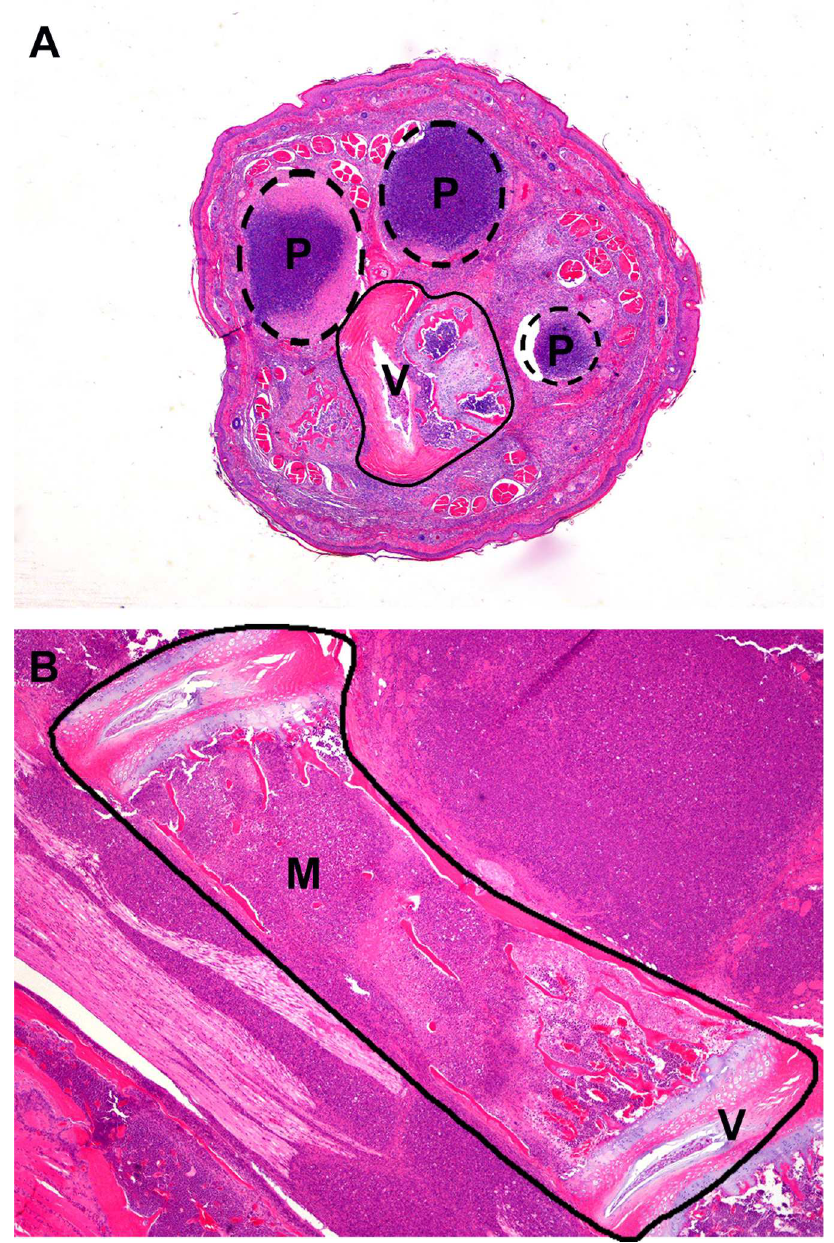
Fig 3. Histopathology observed in mice with rear leg clinical signs assocaited with IP challenge with B . pseudomallei K96243.(A) C57BL/6euthanizedon day 22 post-infection showingclinicalsigns in the hind-endand tail. Tail, transverse section: Multiple pyogranulomas partially effacing vertebral body and associated soft tissues. H&E, 20X. (B) BALB/c mouse euthanized on day 25 post-infection with rear-leg paralysisand laboredbreathing.Lumbarspine, longitudinal section: Pyogranulomatous inflammation partially effacing vertebral body and associatedsoft tissues. P = pyogranuloma; M = marrow cavity; V = vertebral body; H&E,